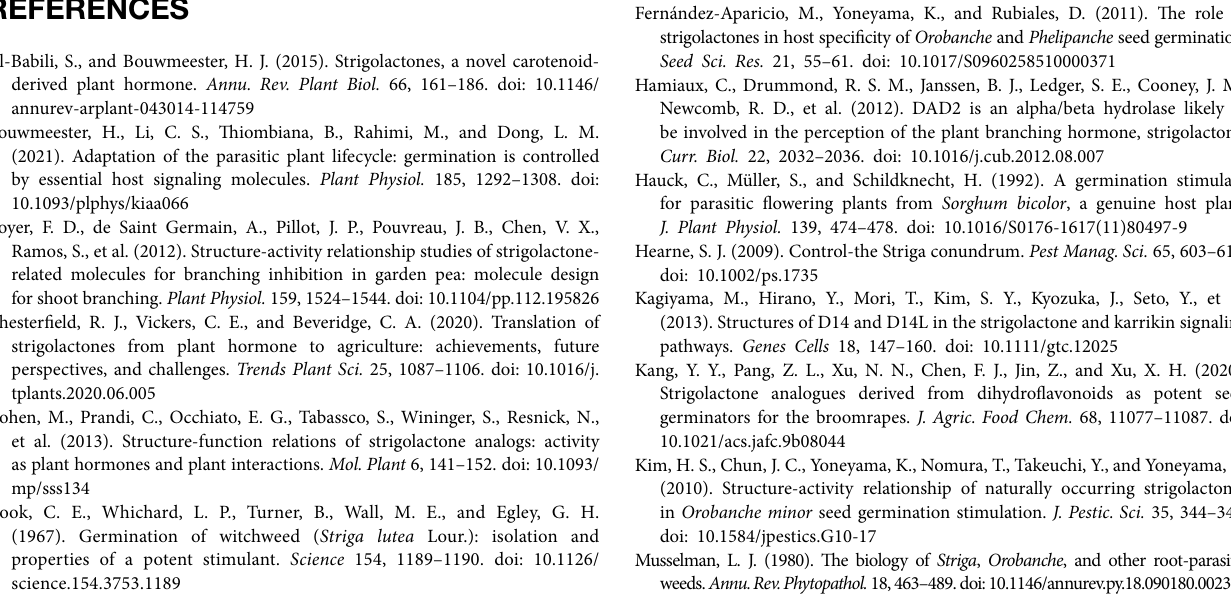
Supplementary Figure S1 | 1 H NMR of 7BrGR24. Supplementary Figure S2 | 13 C NMR of 7BrGR24. Supplementary Figure S3 | 1 H NMR of 7FGR24. Supplementary Figure S4 | 13 C NMR of